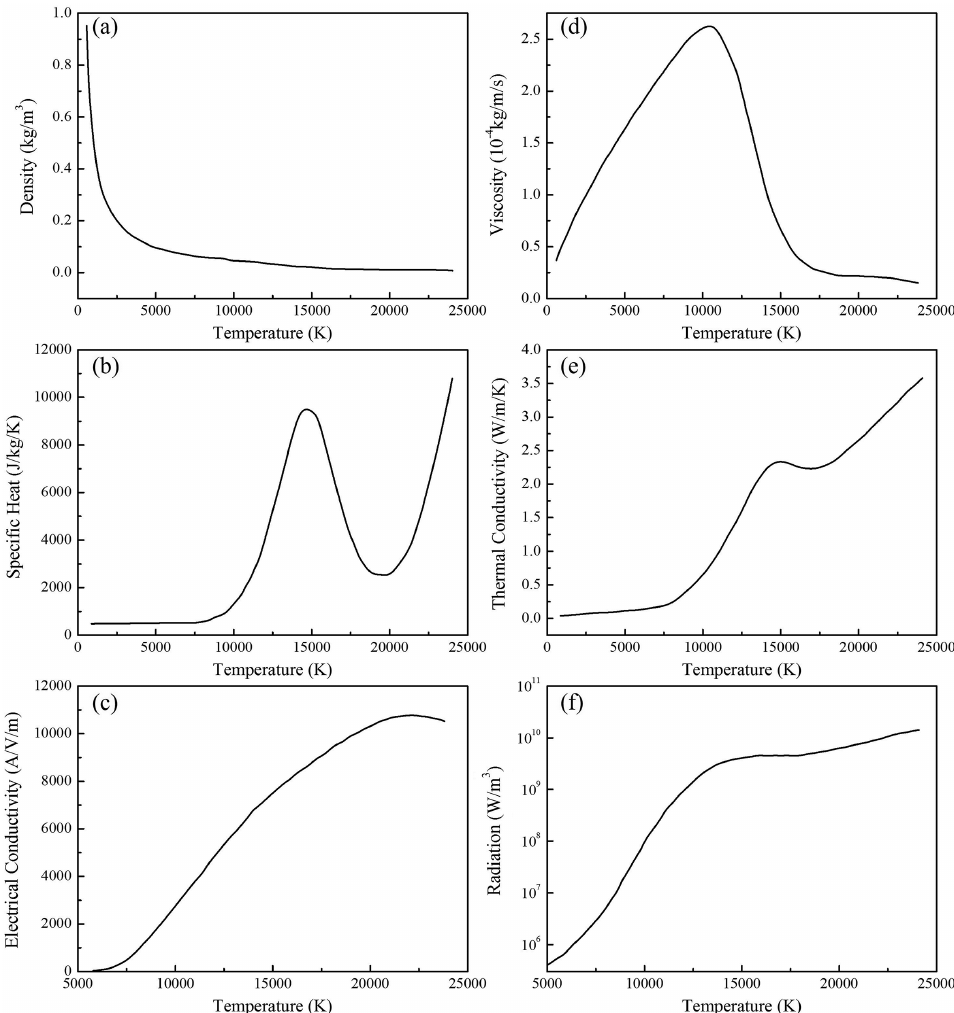
Figure 2: Thermophysical properties [8, 9] of argon plasma for